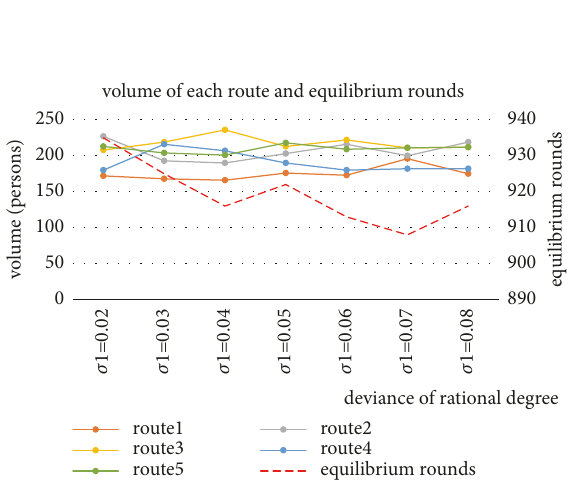
Figure 5: Volume evolution of five routes for 𝑞 = 1000 , 𝛼 = 0.3 , 𝜃 = 0.2 , Δ ∼ 𝑁(0.2, 𝜎 ) . 𝑖 𝑖 1